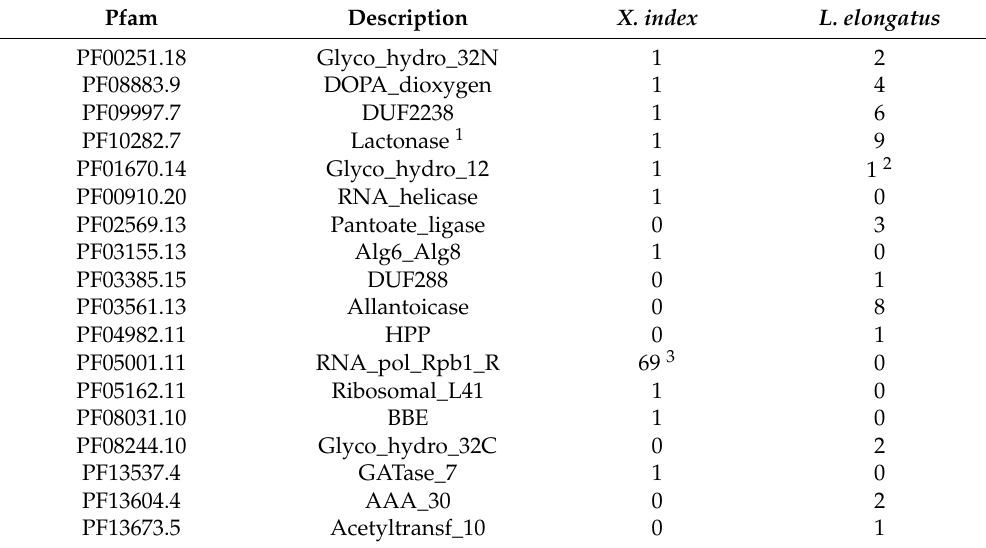
Table 2. Pfam domains only present in Horizontal Gene Transfer (HGT) candidates of X. index and L. elongatus (numbers refer to occurrences of domains, not transcripts).